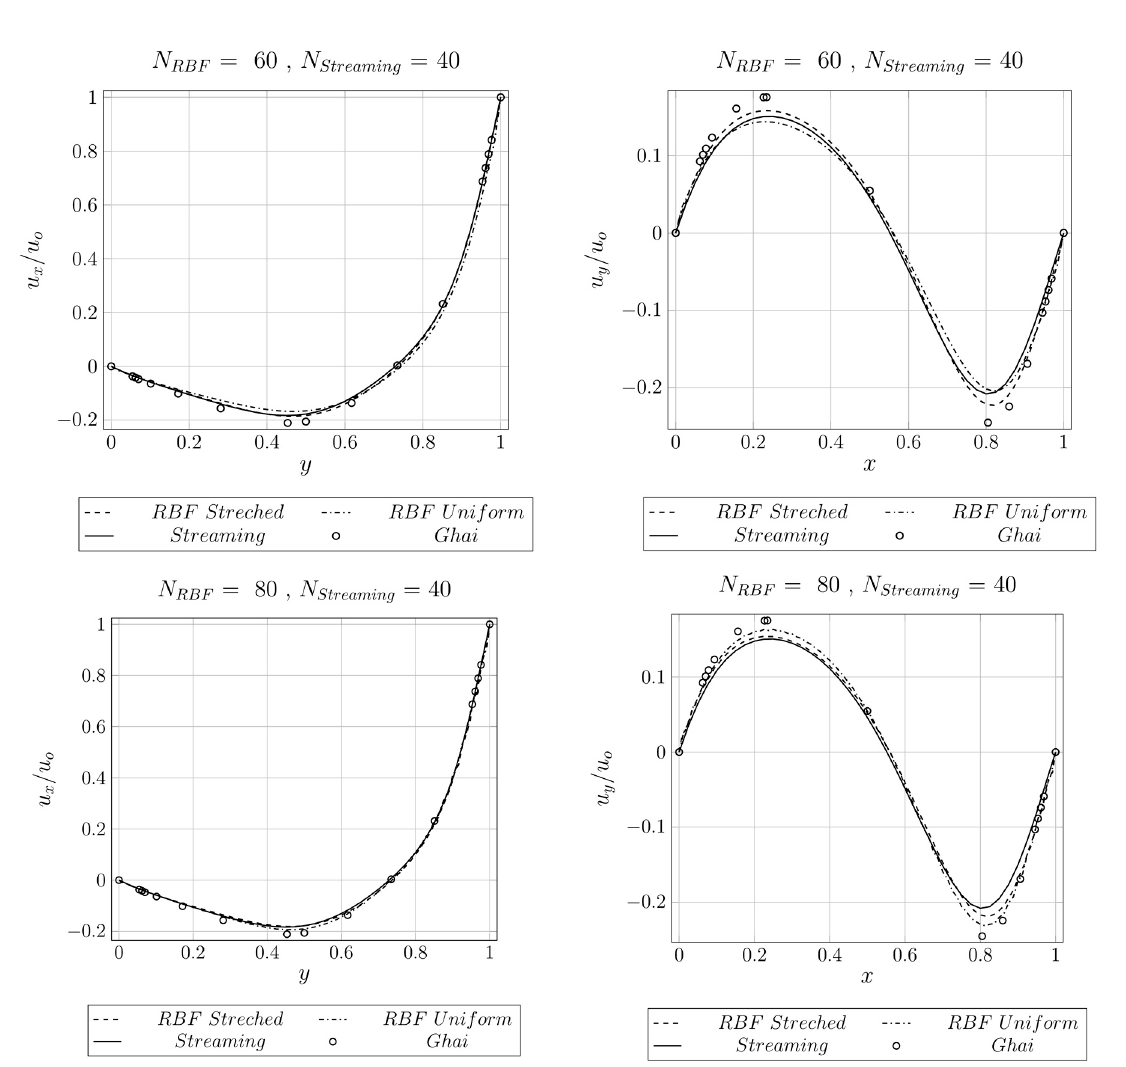
Figure 6. Lid ‐ driven cavity solved using streaming with 40 ‐ mesh and RBF interpolation with 40 ‐ mesh uniform and stretched.